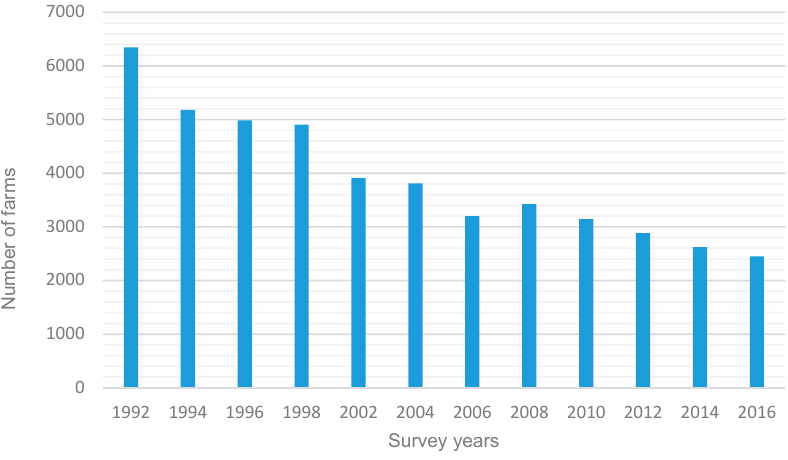
Figure 1. The total number of arable farms in Northern Ireland 1992–2016.